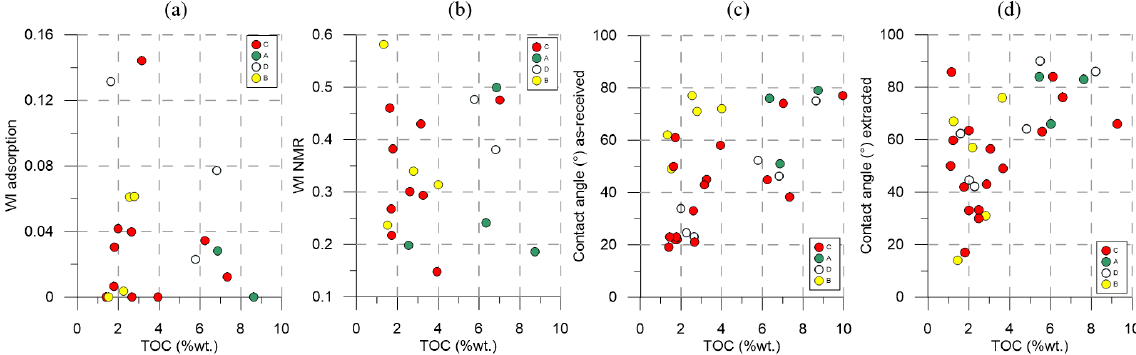
Figure 5. Crossplots showing correlations of TOC vs. (a) WI adsorption, (b) WI NMR, and vs. contact angle for rock in (c) as-received state and (d) extracted state with indication of the OM